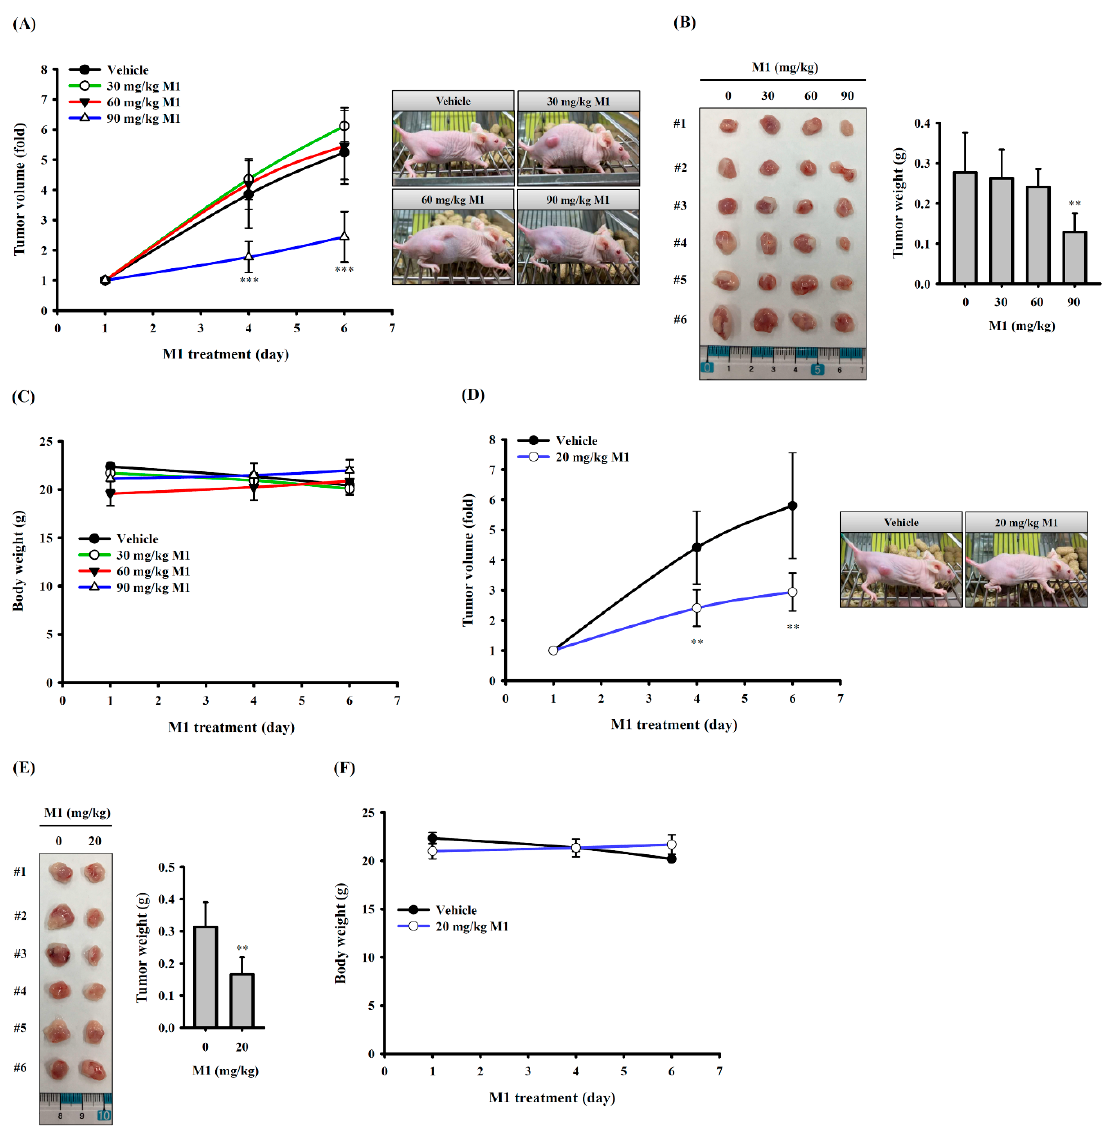
Figure 8. Ginsenoside M1 reduced human oral cancer growth in mice. Tumor volume ( A ), tumor weight ( B ), and body weight ( C ) of mice oral administration of ginsenoside M1 or vehicle. Tumor volume ( D ), tumor weight ( E ), and body weight ( F ) of mice subcutaneous injection of ginsenoside M1 or vehicle. The data were expressed as mean ± SD; n = 6. ** and *** indicate a significant difference at the level of p < 0.01 and p < 0.001, respectively, compared to vehicle-control mice. (One-way ANOVA with Dunnett’s multiple comparisons test).